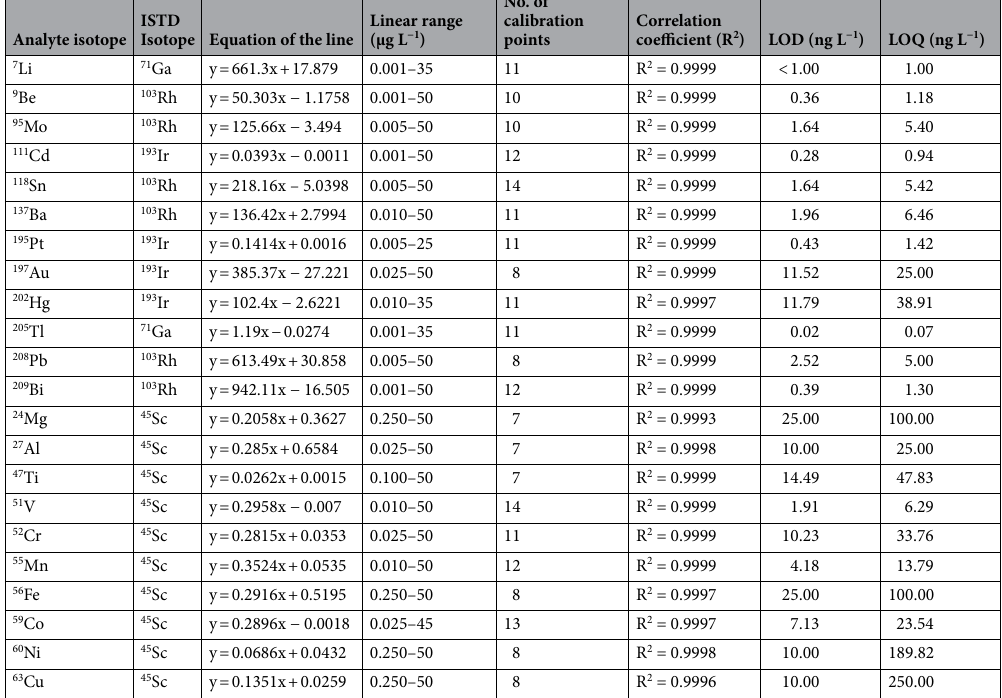
Table 2. Summary of the calibration and quality assurance for each element.